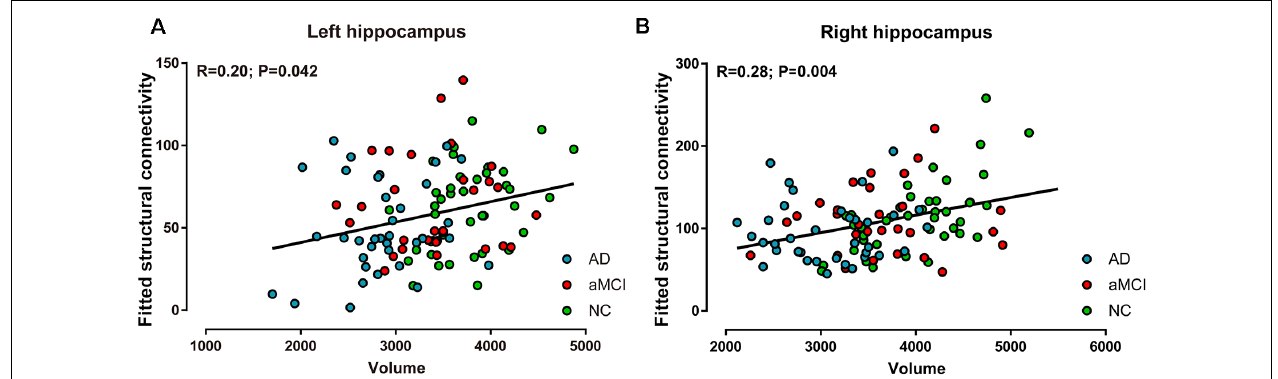
FIGURE 4 | Correlations between volume and structural connectivity (sum of the number of connecting fibers) in the bilateral hippocampi in the AD, aMCI, and NC groups. (A) Volume was positively correlated with structural connectivity in the left hippocampus. (B) Volume was positively correlated with structural connectivity in the right